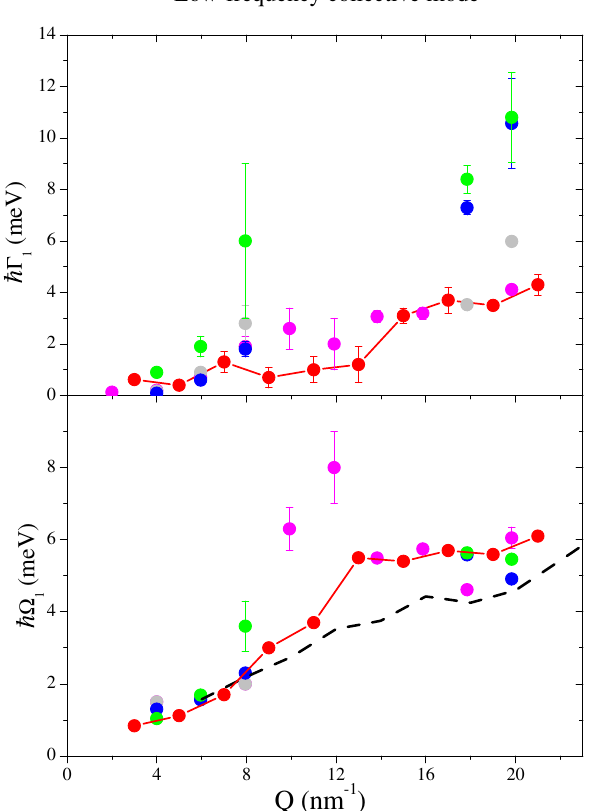
Figure 3. Data are the same as in Fig. 2, but they refer to the low frequency DHO; the dashed line here represents the results of a joint IXS and INS measurement on heavy water 5 . Symbols as in the legend of Fig.